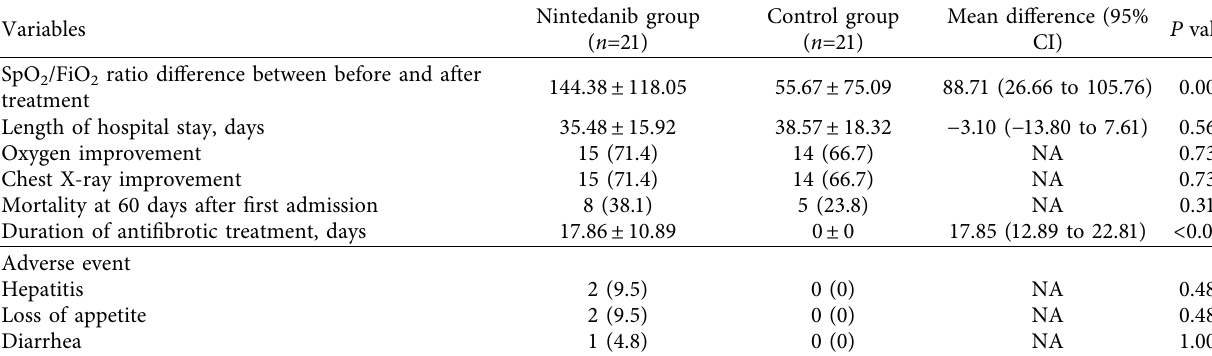
Table 2: Clinical outcomes of hospitalized patients with COVID-19 pneumonia.